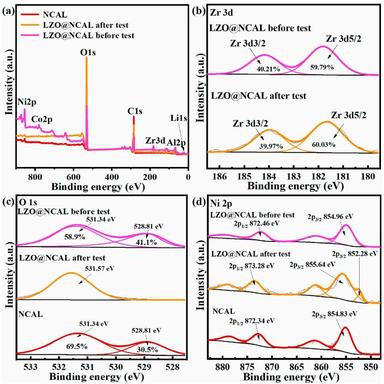
XPS spectra of (a) survey, (b) Zr 3d, (c) O 1s, (d) Ni 2p for 1 wt % LZO@NCAL samples before test, 1 wt % LZO@NCAL anode after test and NCAL.